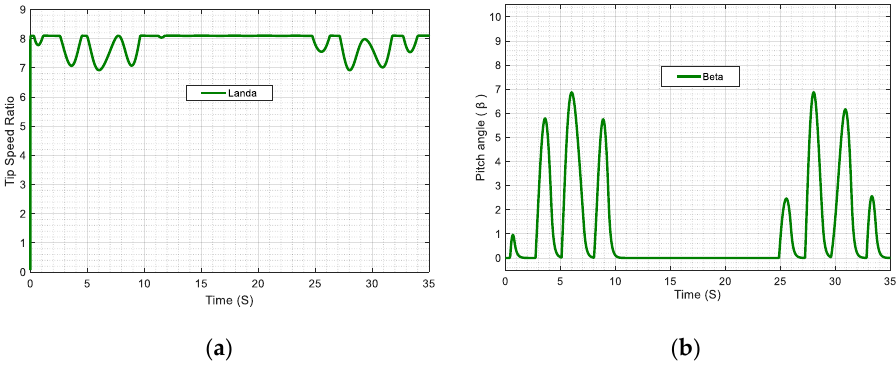
Figure 9. ( a ) Tip speed ratio ( 𝜆 ); ( b ) pitch angle variations (β).